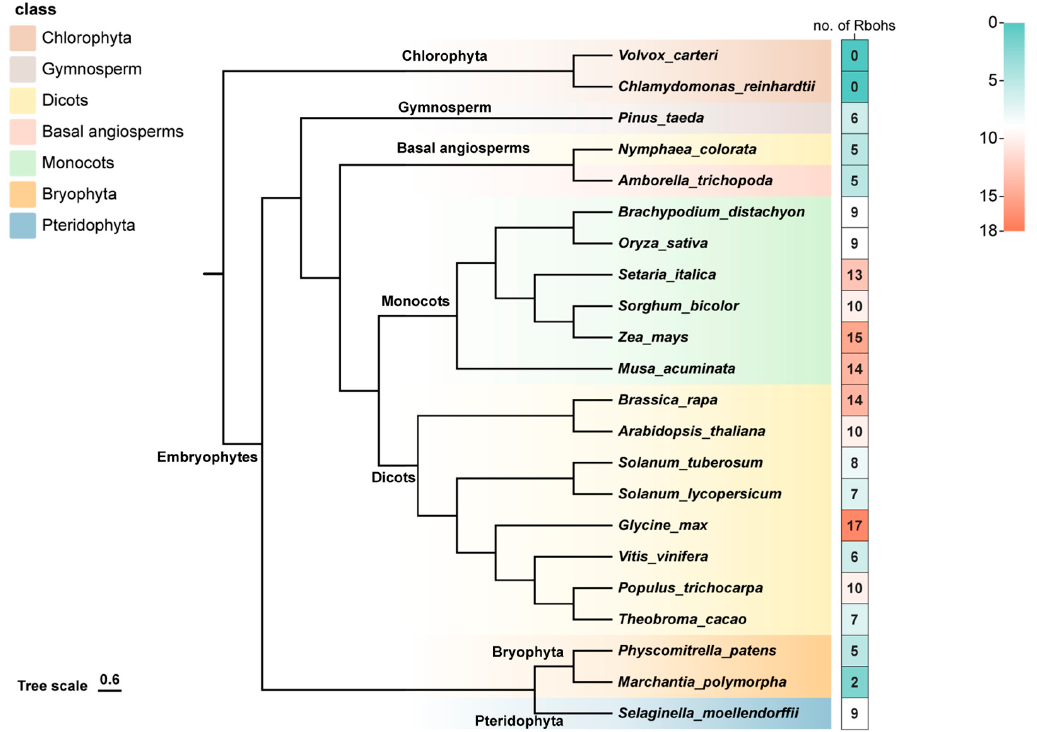
Figure 1. Evolutionary relationships of respiratory burst oxidase homologue (RBOH) genes among 22 plant species.